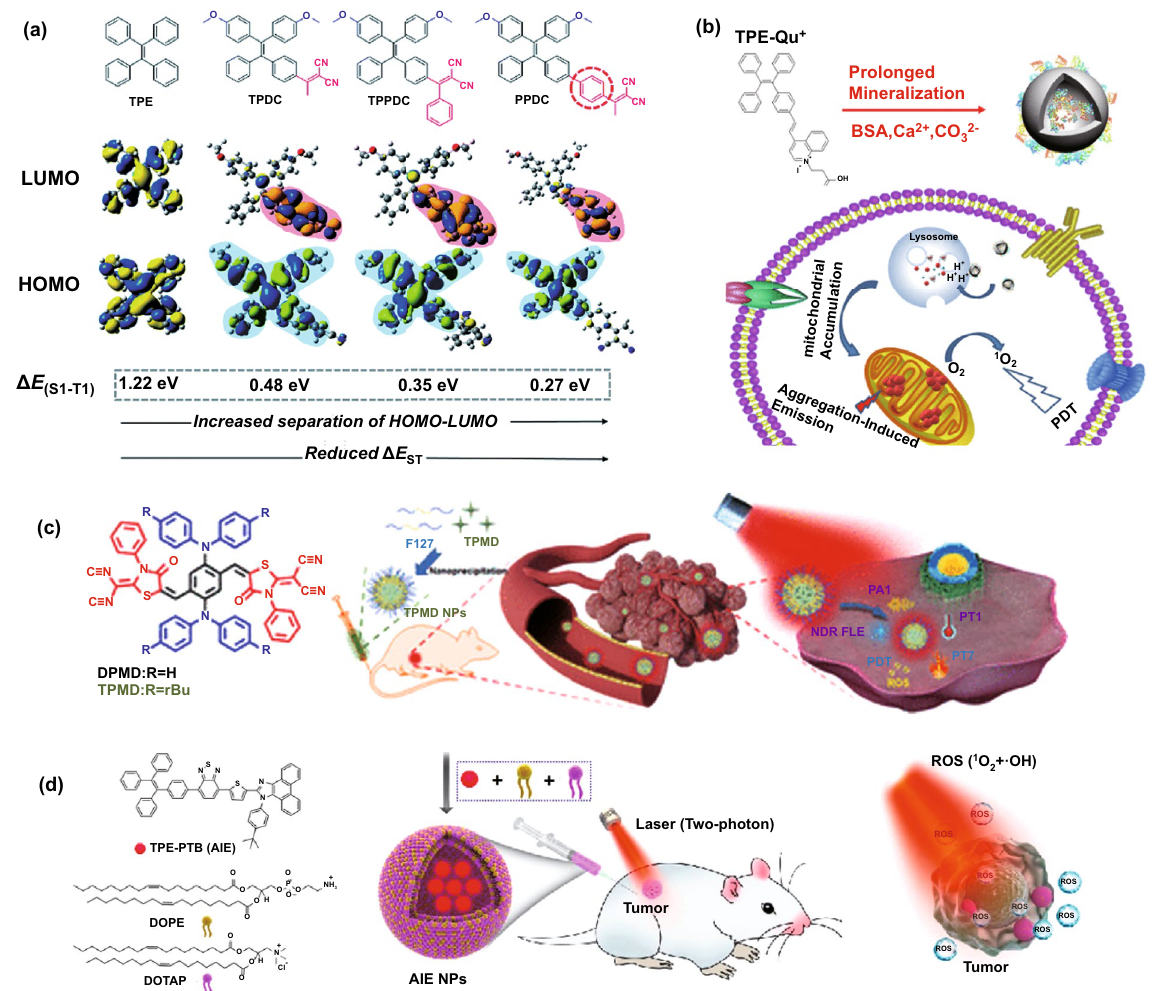
Fig. 4 a Chemical structures and HOMO–LUMO distributions of AIE photosensitizers designed by introducing different donor and acceptor groups to the TPE molecule and its effect on Δ E ST , reproduced from Ref. [11] with permission from the Royal Society of Chemistry. b Molecu- lar structure of TPE-Qu + AIE photosensitizer, its nanoparticle formation via mineralization, and decomposition of TPE-Qu + -loaded CaCO 3 nan- oparticles inside the target cell, reproduced from Ref. [88] with permission from American Chemical Society. c Molecular structure of TPMD AIE photosensitizer and its encapsulation into nanoparticle using P127 for PDT and PTT applications, Reproduced from Ref. [89] with permis- sion from American Chemical Society. d Design and Preparation of lipid-encapsulated TPE-PTB-based AIE nanoparticles for two-photon fluo- rescence imaging-guided photodynamic therapy application, reproduced from Ref. [91] with permission from American Chemical